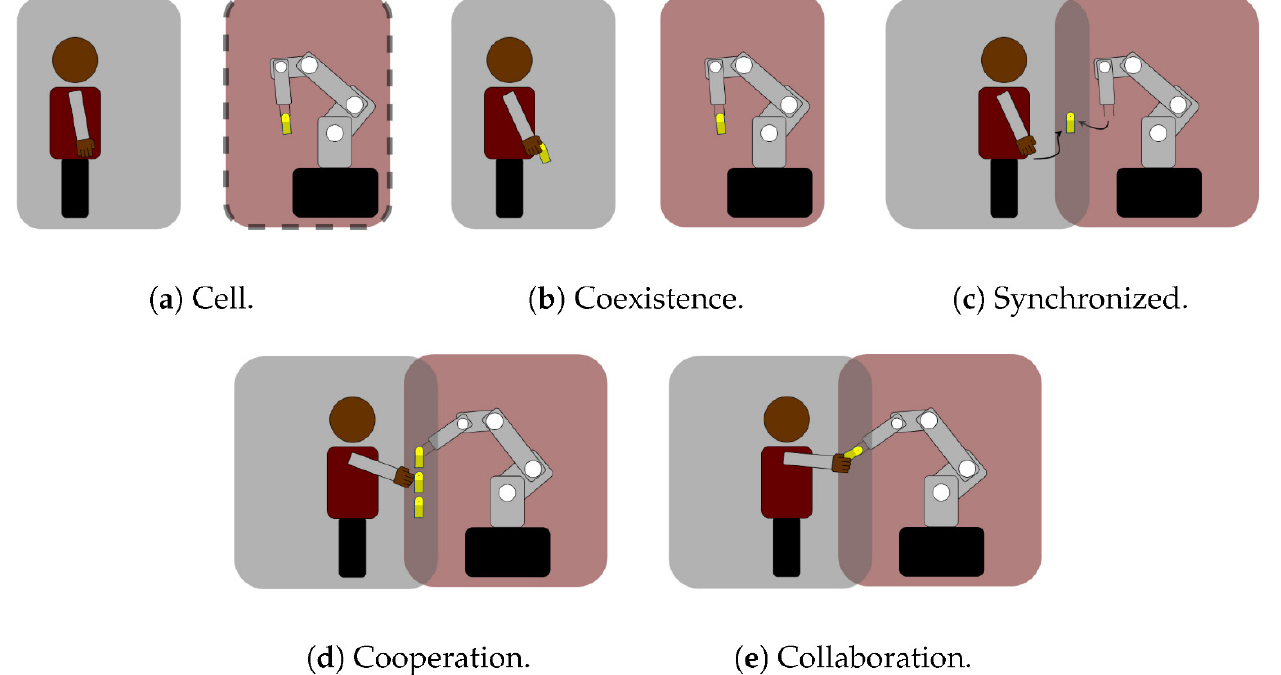
Figure 2. Human–robot cooperation levels [5]: ( a ) no collaboration, the robot remains inside a closed work cell; ( b ) coexistence, removed cells, but separate workspaces; ( c ) synchronisation, sharing of the workspace, but never at the same time; ( d ) cooperation, shared task and workspace, no physical interaction; ( e ) collaboration, operators and robots exchange forces.